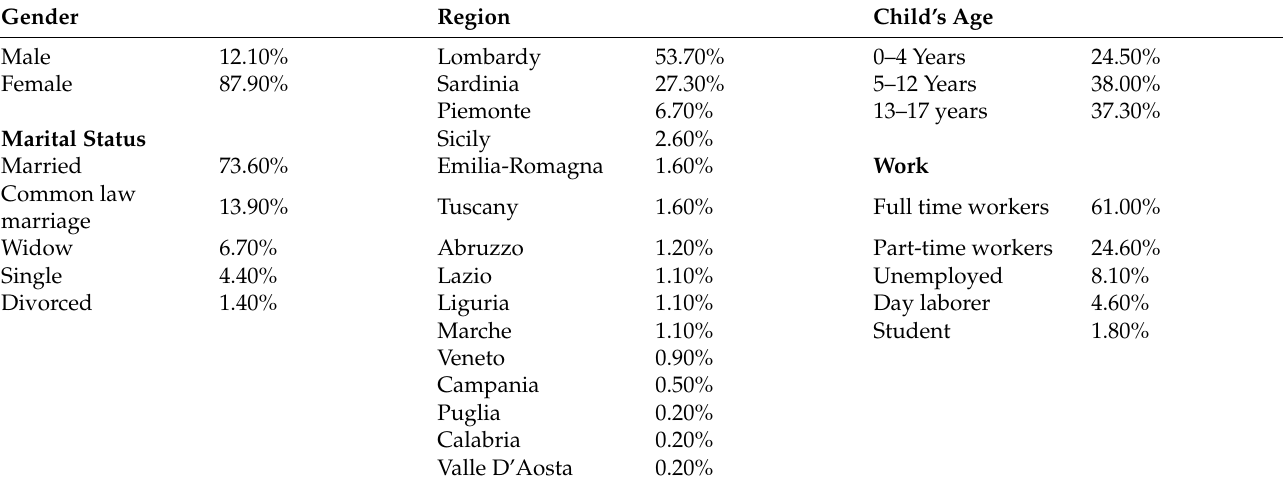
Table 1. Demographics of the sample, described for variables and